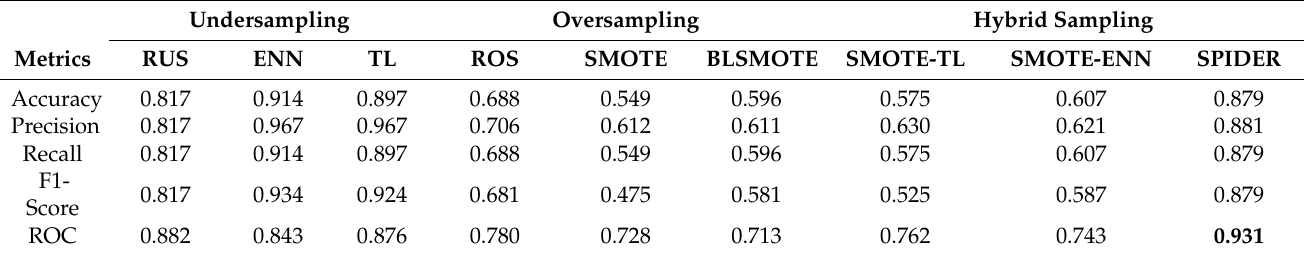
Table 5. Effect of resampling techniques on SVM classifier